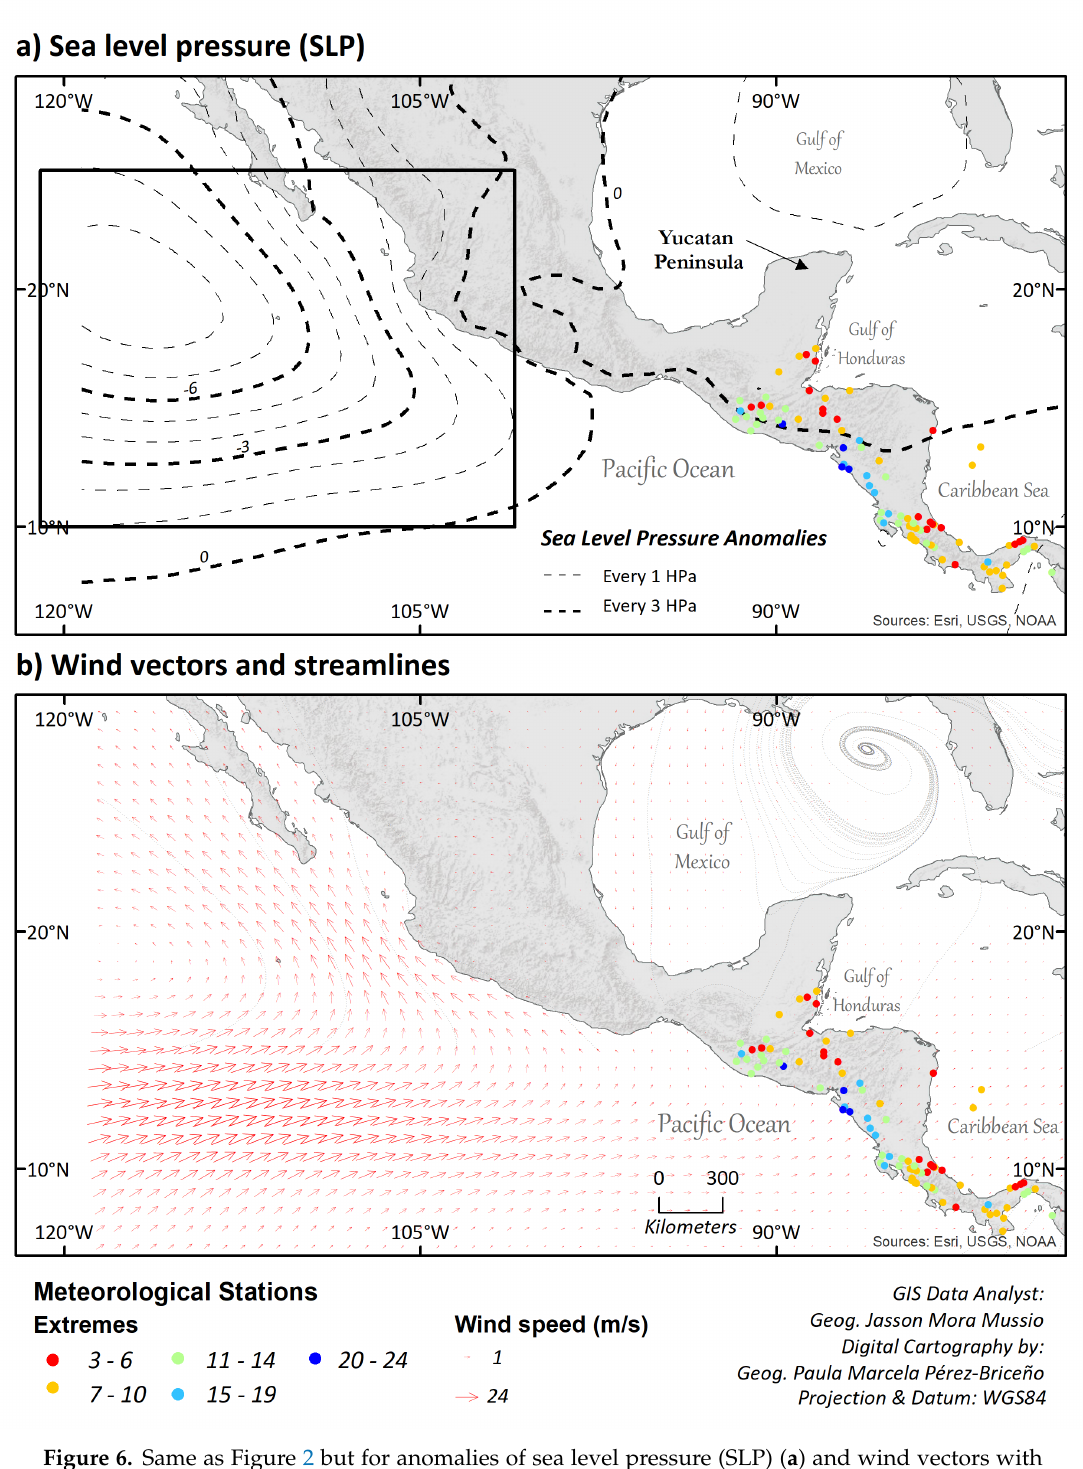
Figure 6. Same as Figure 2 but for anomalies of sea level pressure (SLP) ( a ) and wind vectors with associated streamlines ( b ) for a Pacific Ocean box 10 ◦ N to 25 ◦ N and 101 ◦ W to 121 ◦ W. SLP contours every 1 hPa (thin lines) and every 3 hPa (thick